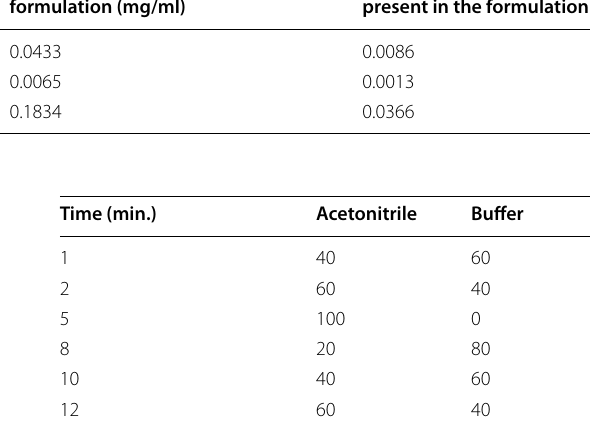
Table 4 Amount of Berberine chloride, Marmelosin, and Negundoside present in Anu Taila formulation S. no.